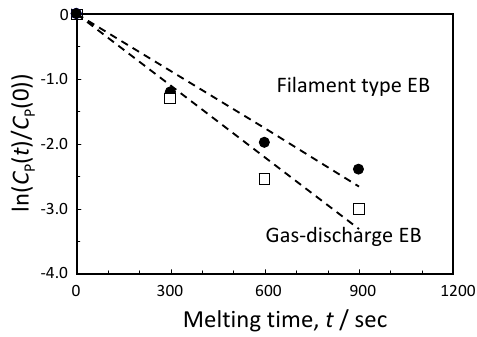
Figure 5. Relation between ln( C P .t/=C P .0// and melting time using filament type and gas-discharge EB.